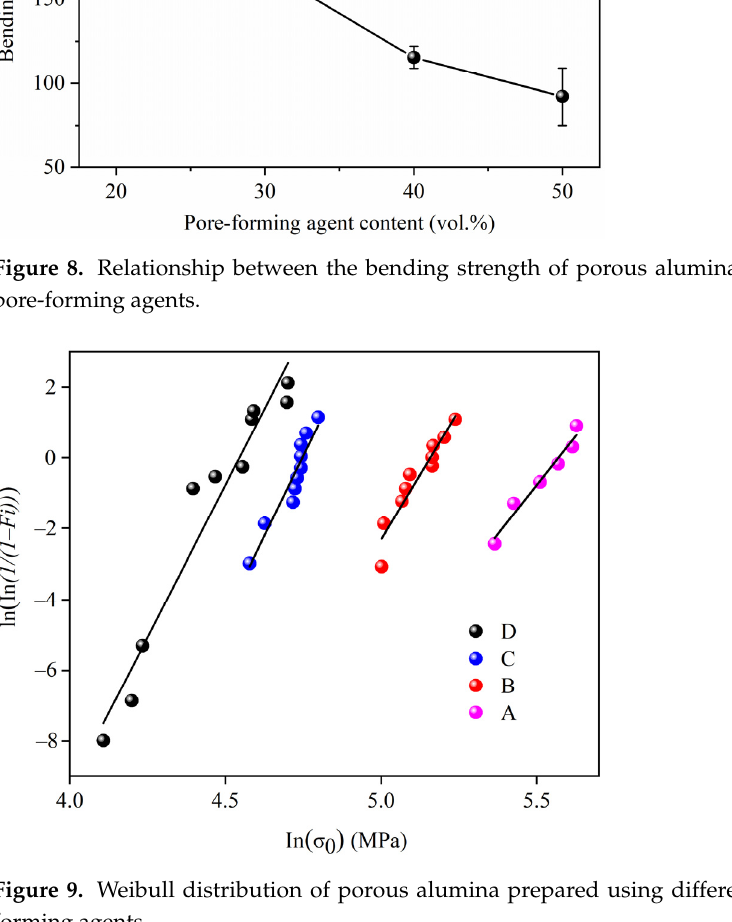
pore-forming agents. forming